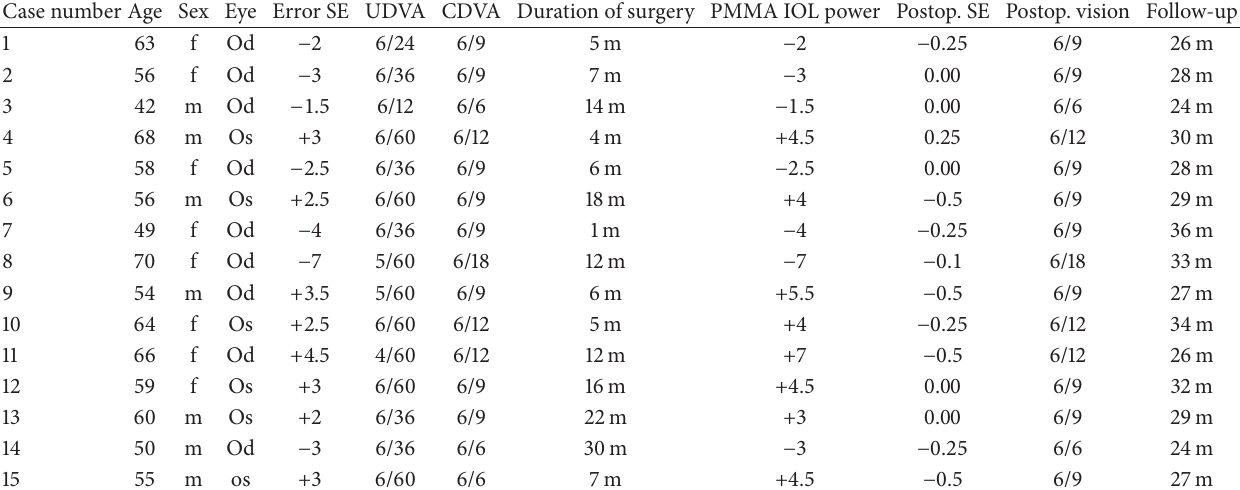
Table 1: The collected data for each